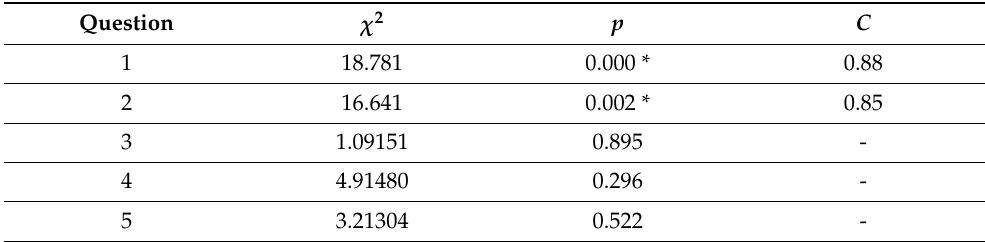
Table 1. Results of χ 2